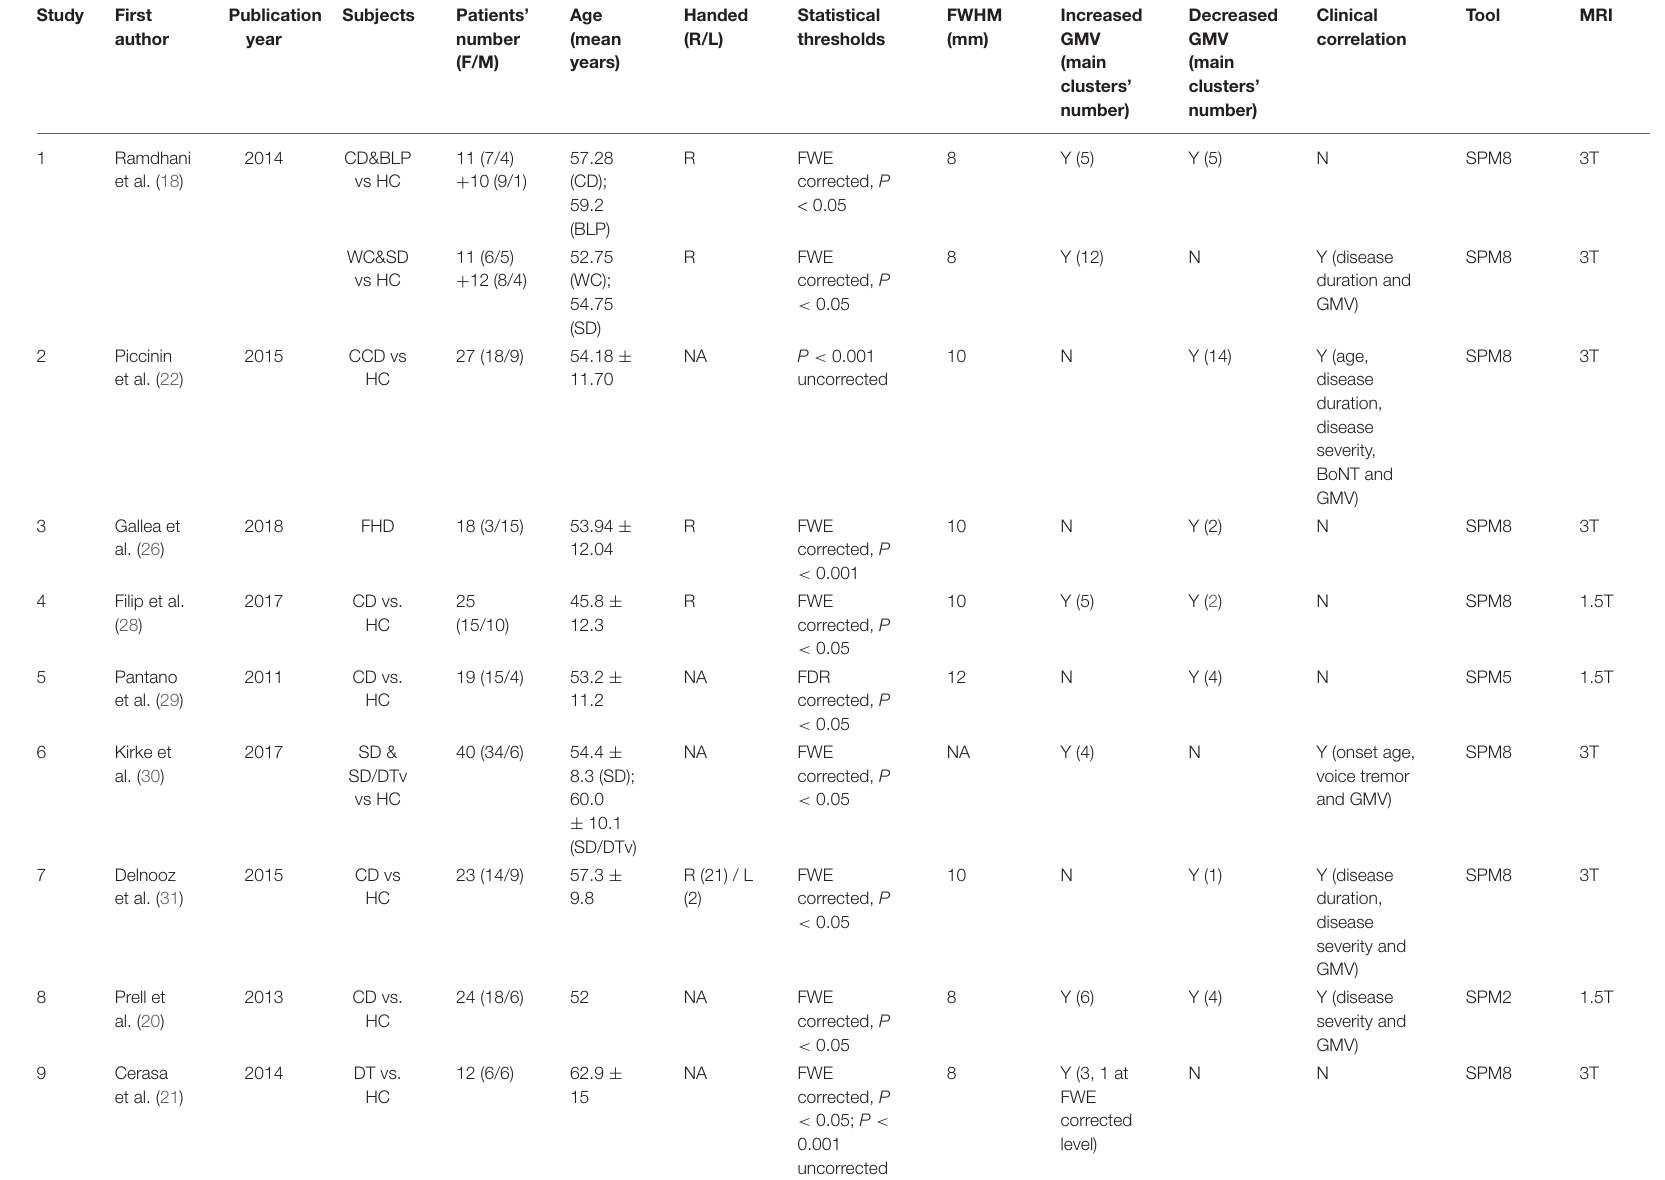
TABLE 2 | Summary of inclusive studies in